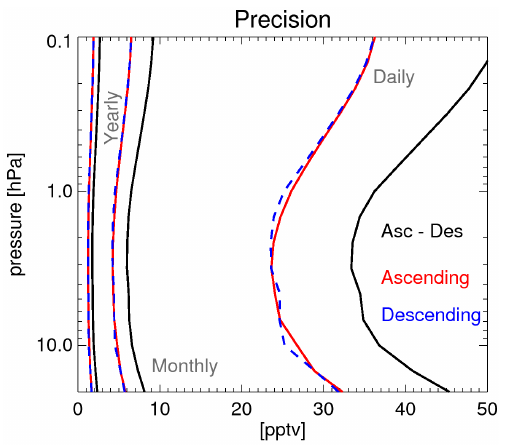
Fig. 4. Expected precision for a daily, monthly and yearly 10 ◦ lat- itude bin. The “Asc − Des” precision is the root sum square of the ascending and descending values.